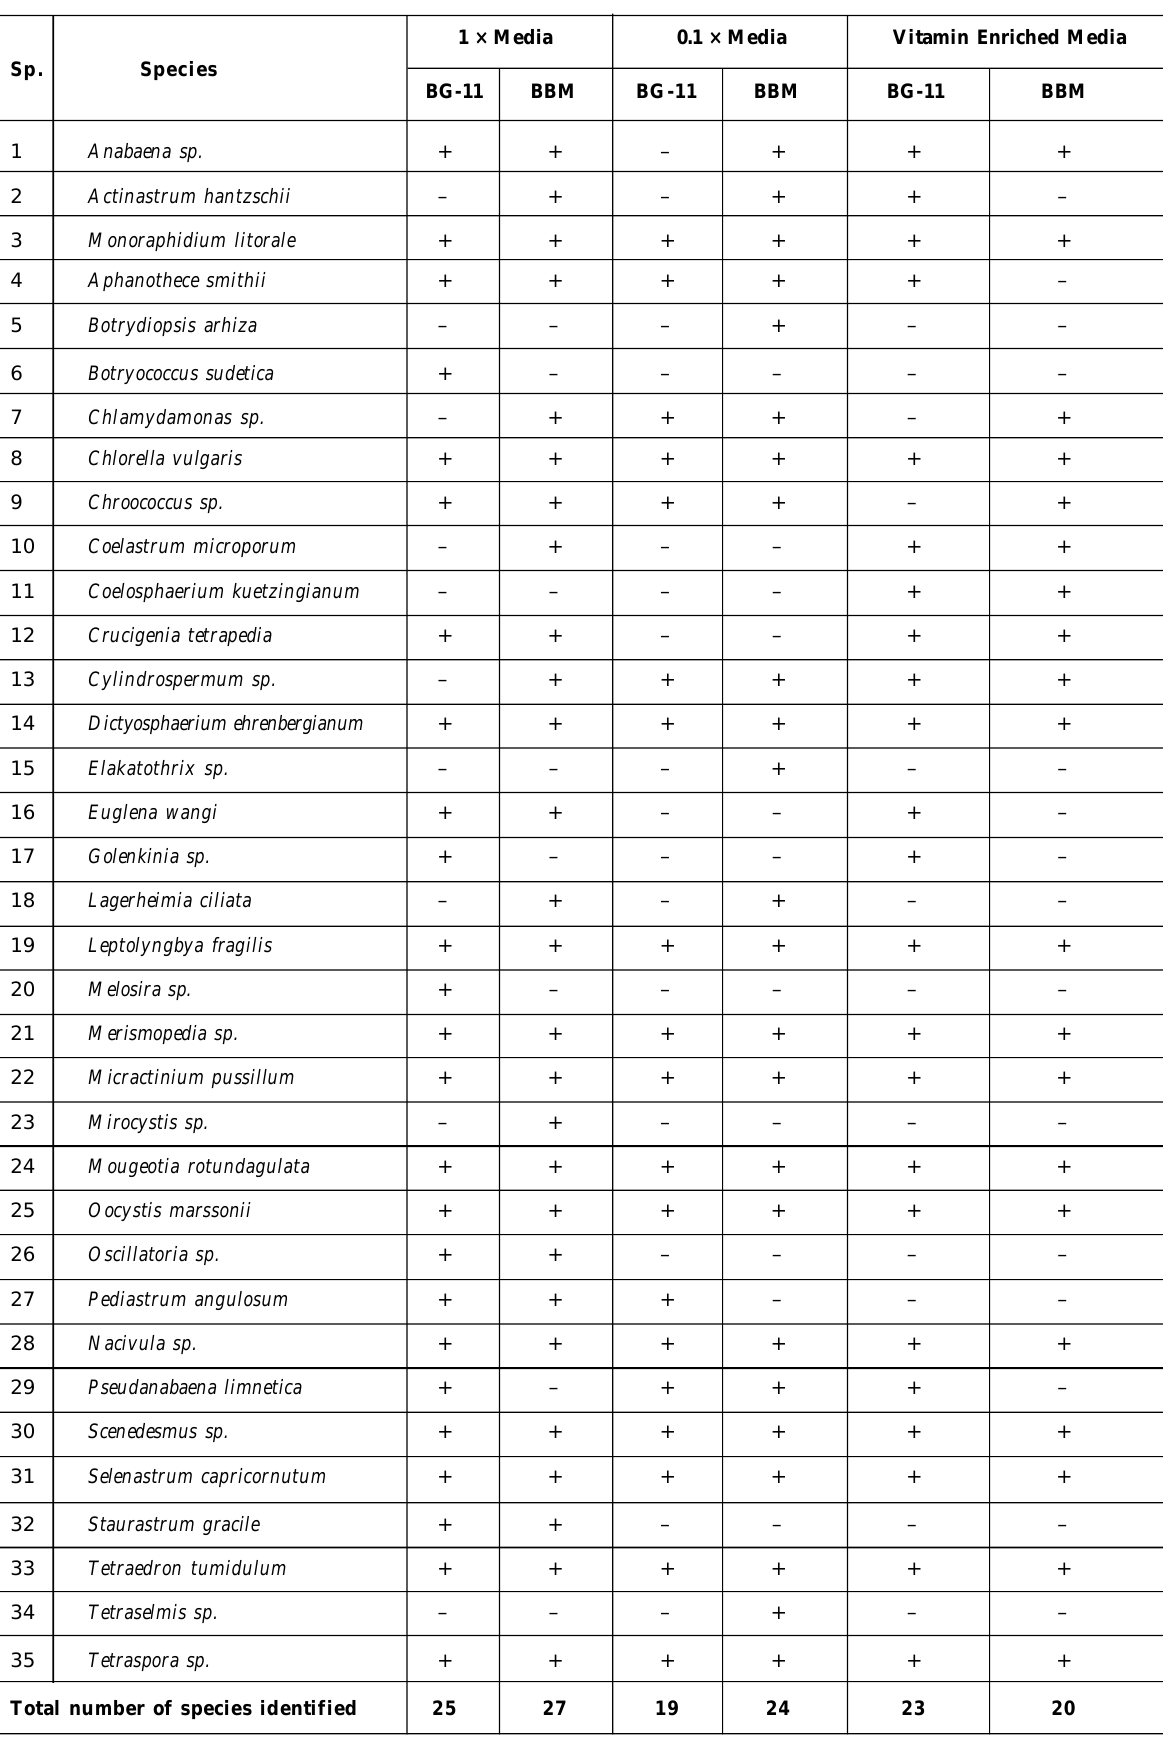
Table 3: List of the morphologically identified algal species across the six deferent media